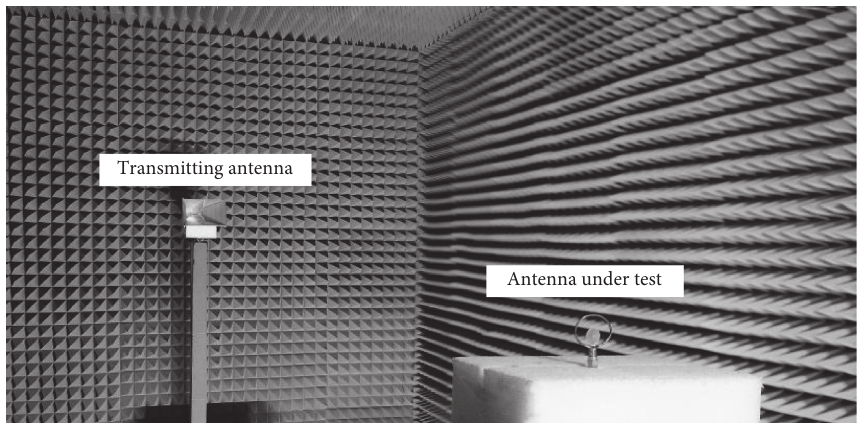
Figure 12: Radiation pattern measurement setup in the anechoic